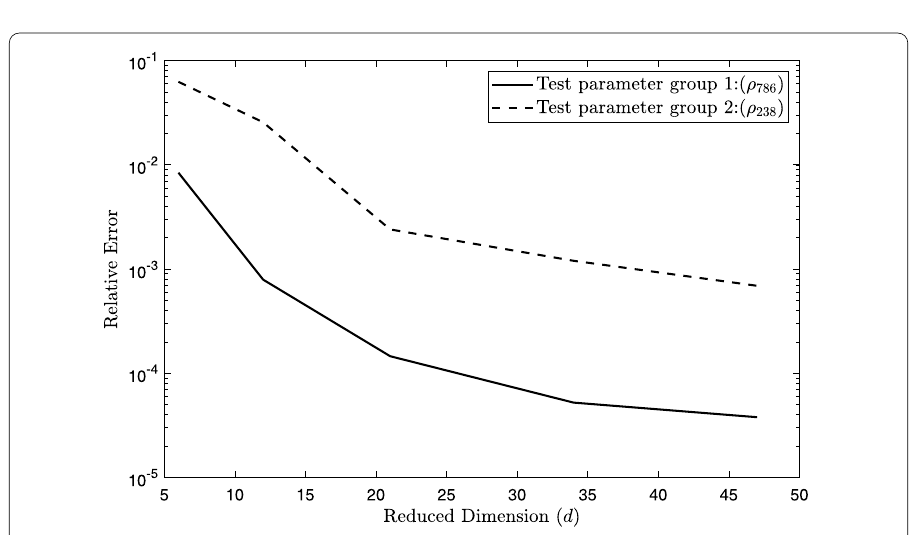
Figure 6 Relative error between full and reduced model for two different parameter groups